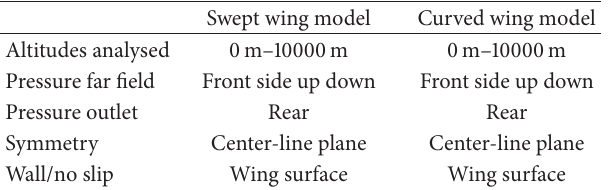
Table 2: CFD boundary